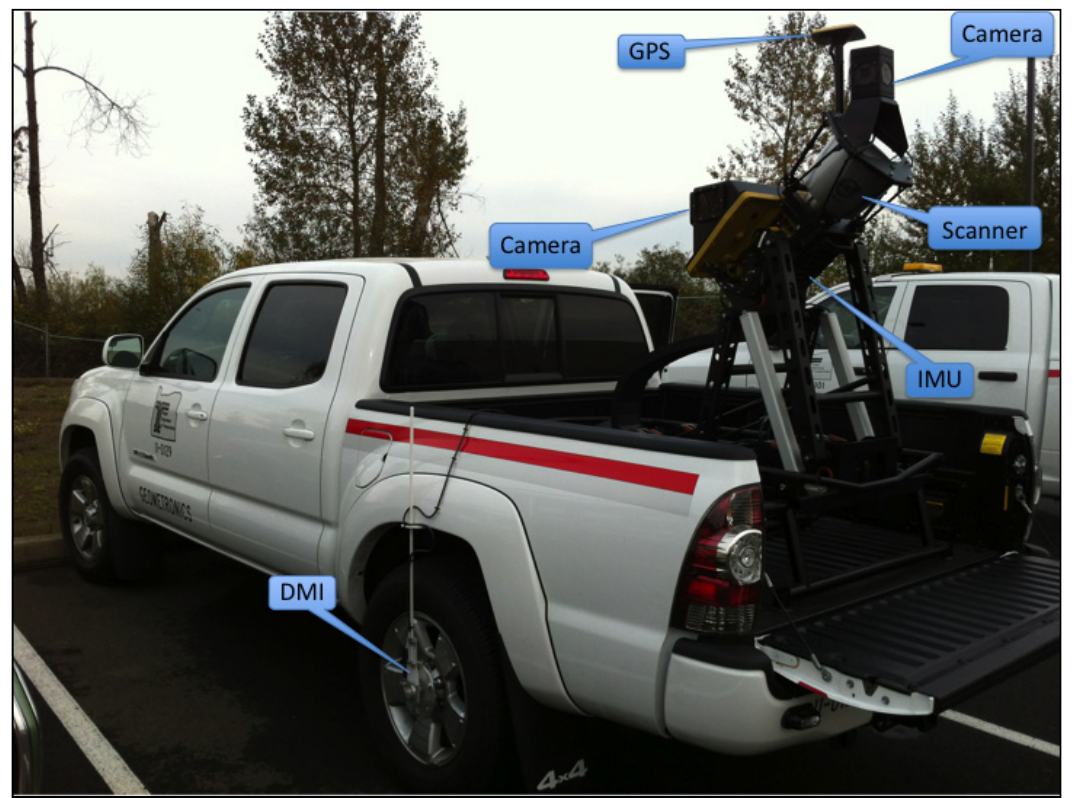
Figure 2. MLS system components (Topcon IP-S2 HD system operated by Oregon